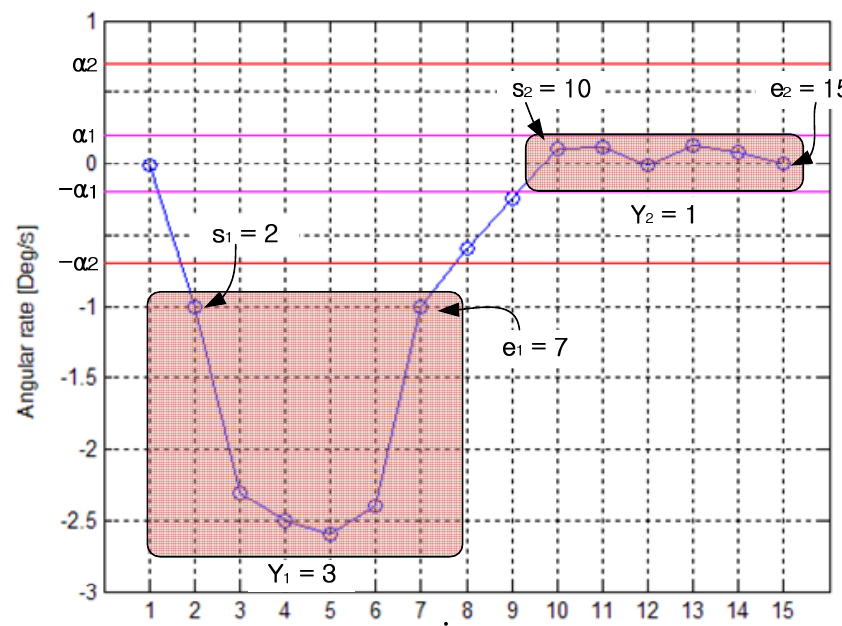
Figure 6. Example of a